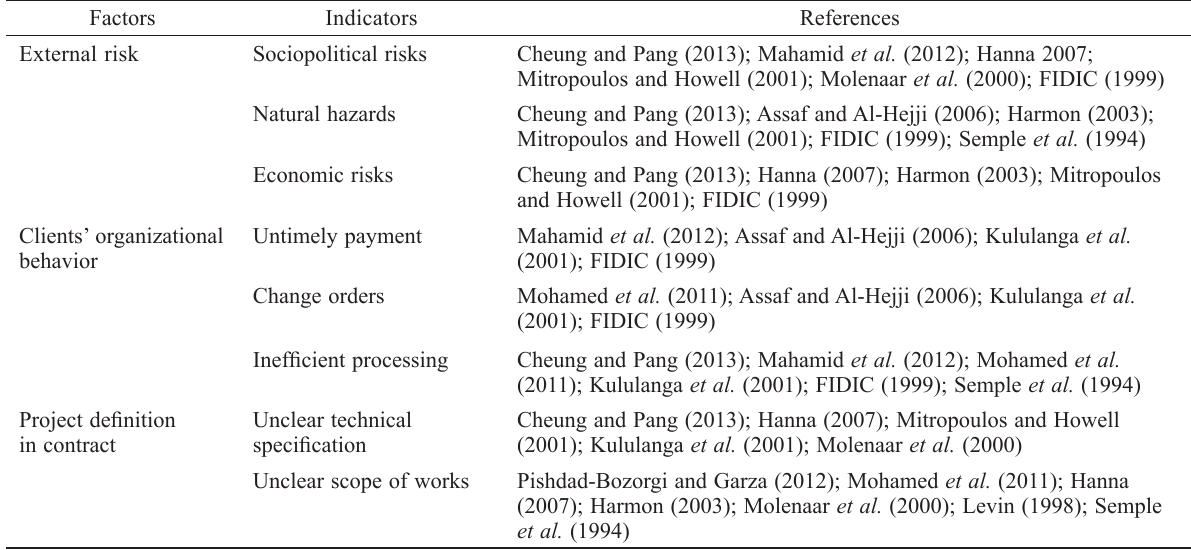
Table 1. Key indicators of the causing factors on contractors’ claims in EPC